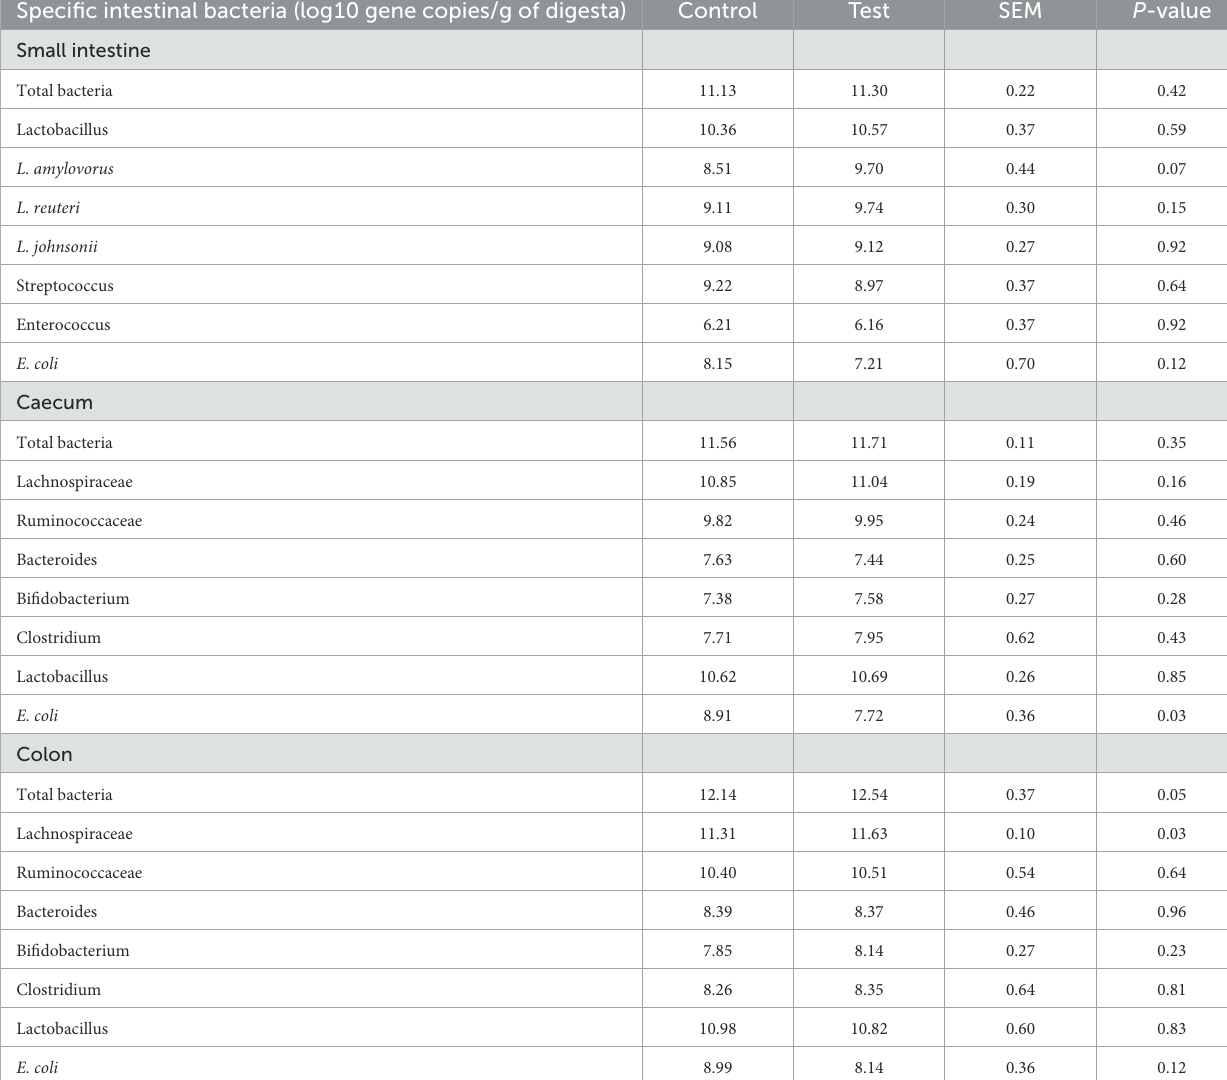
TABLE 7 Specific bacteria in the small intestine (last 25%), caecum and colon of piglets at d14 post-weaning, when fed a control diet (Control; n = 10) or a diet containing 2 kg/ton specific fiber fractions derived from Araceae root and citrus (Test; n = 10) from d0 to d14 post-weaning. Specific intestinal bacteria (log10 gene copies/g of digesta) Control Test